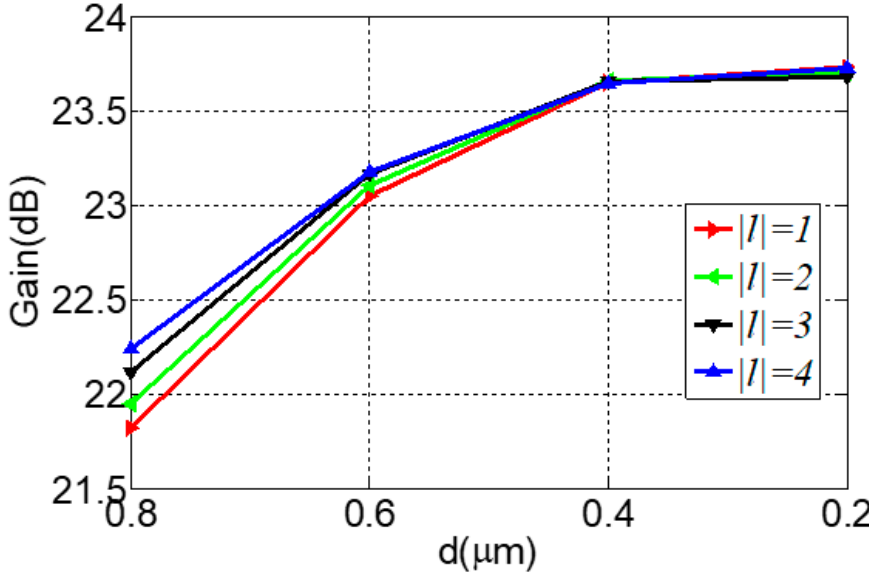
Figure 3. Gain as a function of spacing d at 1550